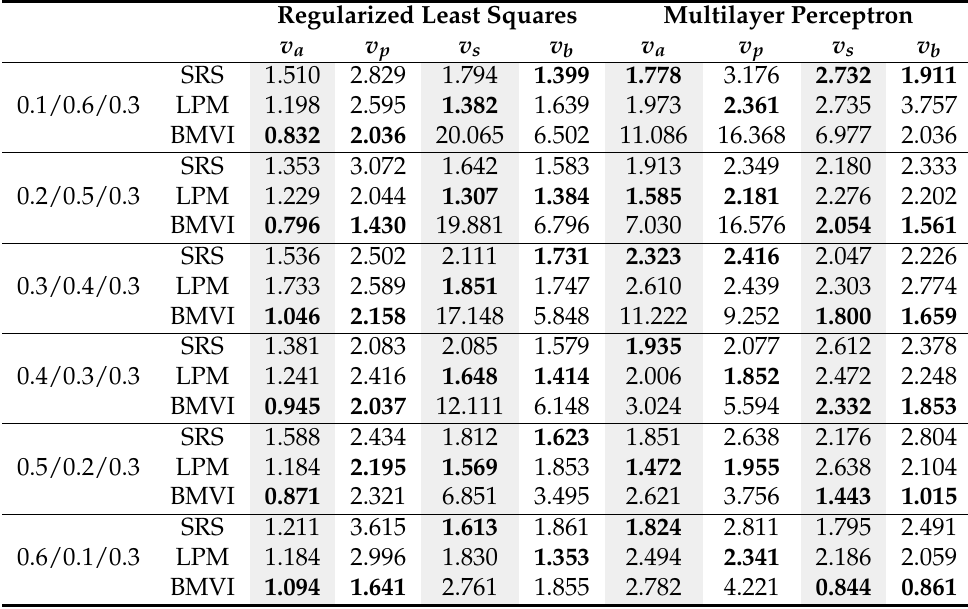
Table 2. Results of population mean µ estimations in terms of MSE. The results are illustrated for all response variables, sampling methods and prediction models. The leftmost column of the table represents different valued sampling fraction vector f introduced in the methods Section 3.5. In each group of three (SRS, LPM, BMVI) the best sampling method is emphasized with a bolded MSE value. The response variables for volume of growing stock (all trees, pine trees, spruce trees, broadleaf trees) are denoted as v a , v p , v s and v b